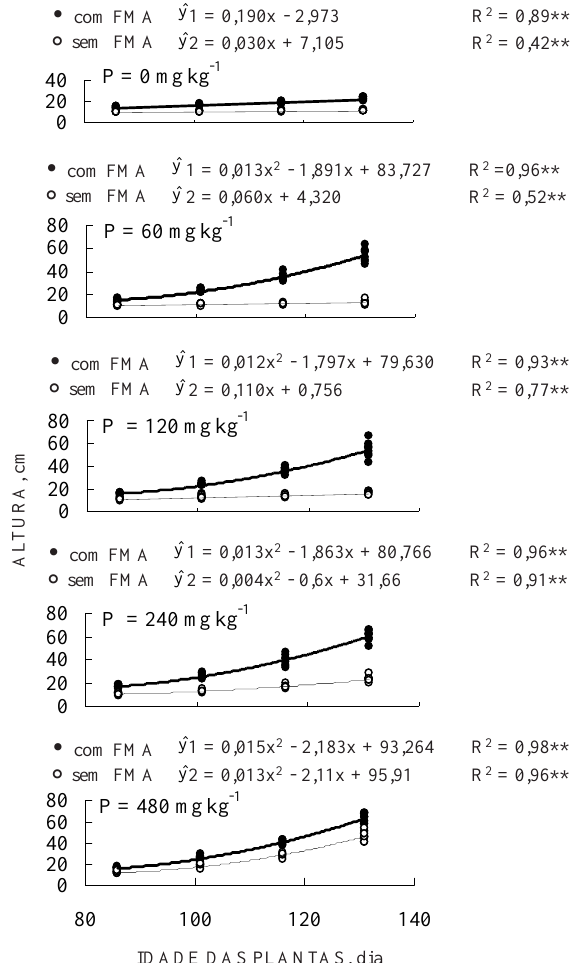
Figura 2. Altura média de plantas de mamoeiro, para cada dose de fósforo adicionada ao substrato, com e sem inoculação com Glomus macrocarpum , considerando a idade das plantas, fase de vaso. Média de quatro repetições. (** significativo a 1 %).